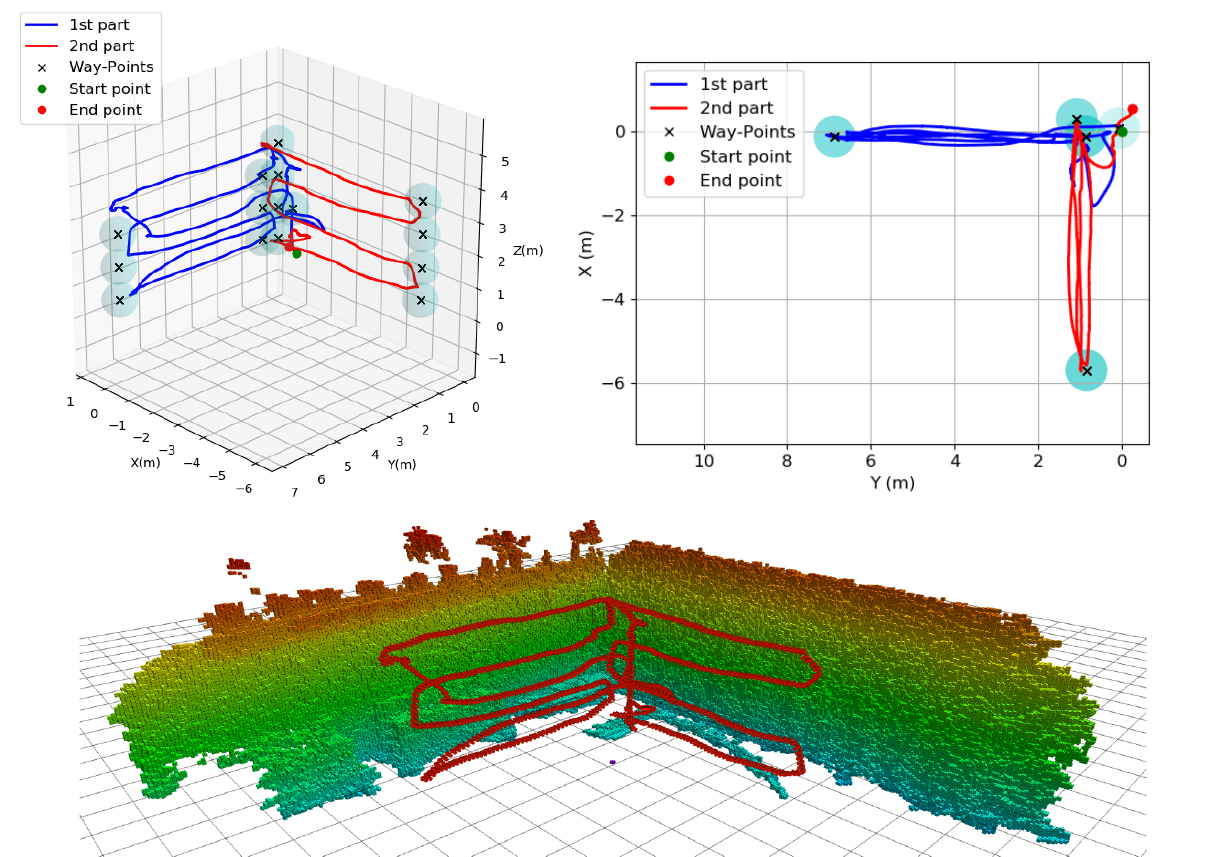
Figure 19. Two sweeping operations in a row: ( top ) estimated paths of the first sweeping (blue) and the second sweeping (red), perspective and 2D projected views are shown; ( bottom ) occupancy grid to show the coverage achieved. (All units are in